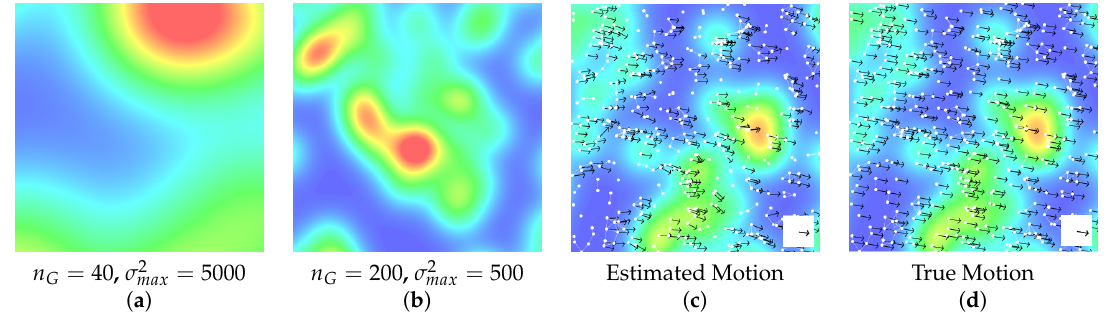
Figure 4. Homogenous field ( a ); and more heterogeneous, non-linear field ( b ). Randomly-distributed set of nodes with simulated spatio-temporal field and estimated ( c ) and true ( d ) field motion per time step. Red indicates high, blue zero field